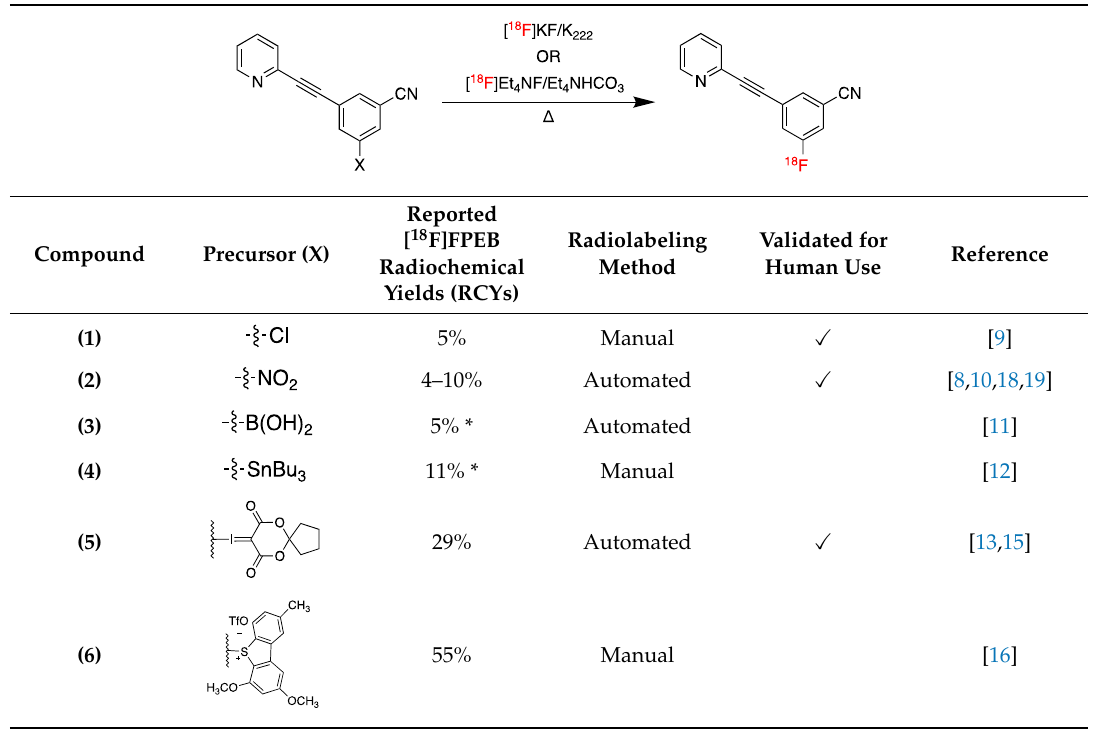
Table1. Reported Radiosyntheses of [ 18 F]FPEB.